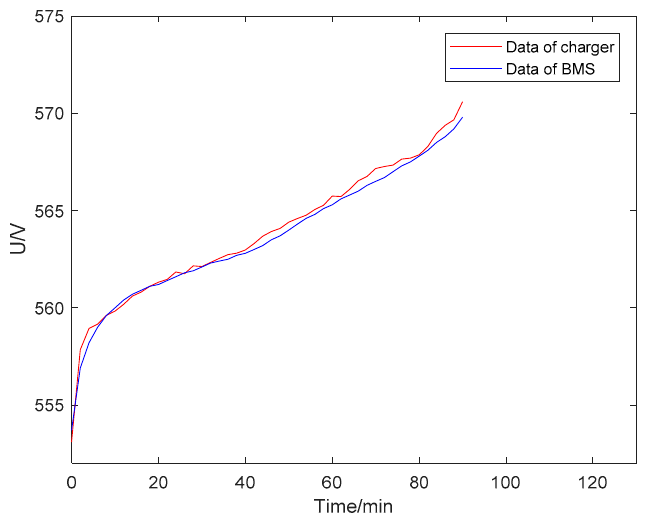
Figure 12. Comparison of voltage calculation data of battery model and voltage data provided by BMS.